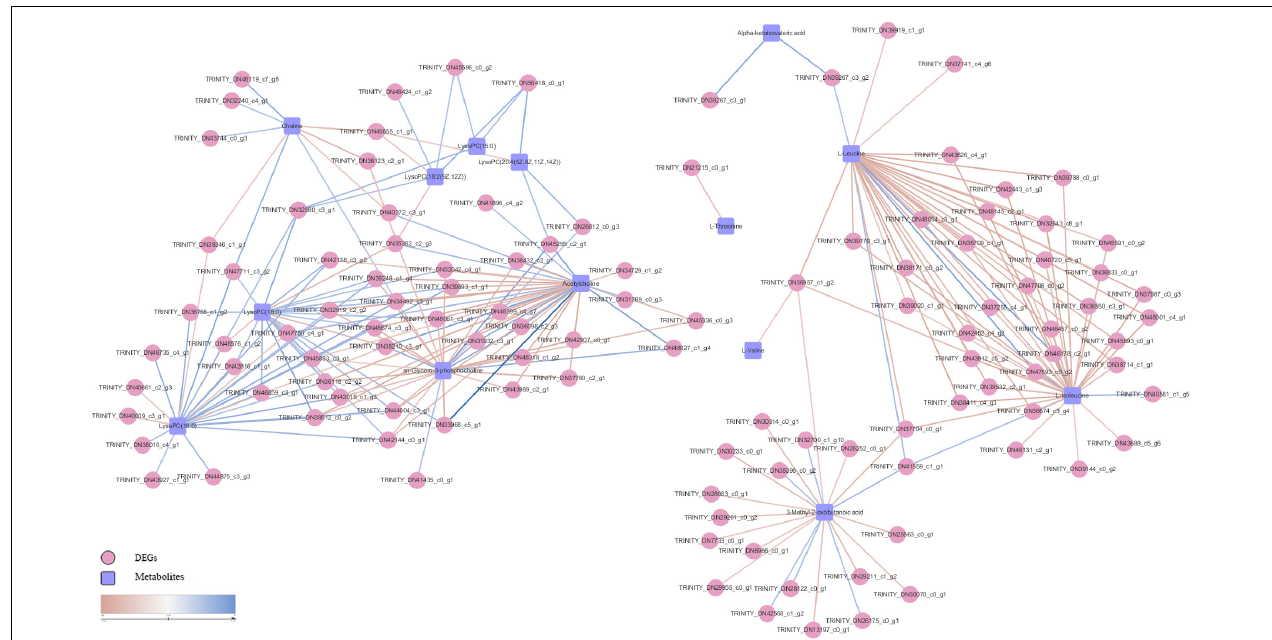
FIGURE 9 | S. insularis metabolome and transcriptome Co-pathway related DEGs and metabolites interaction network. The pink circles represent DEGs. The blue squares represent differential metabolites. The color of the line represents correlation, red represents negative correlation, and blue represents positive correlation.